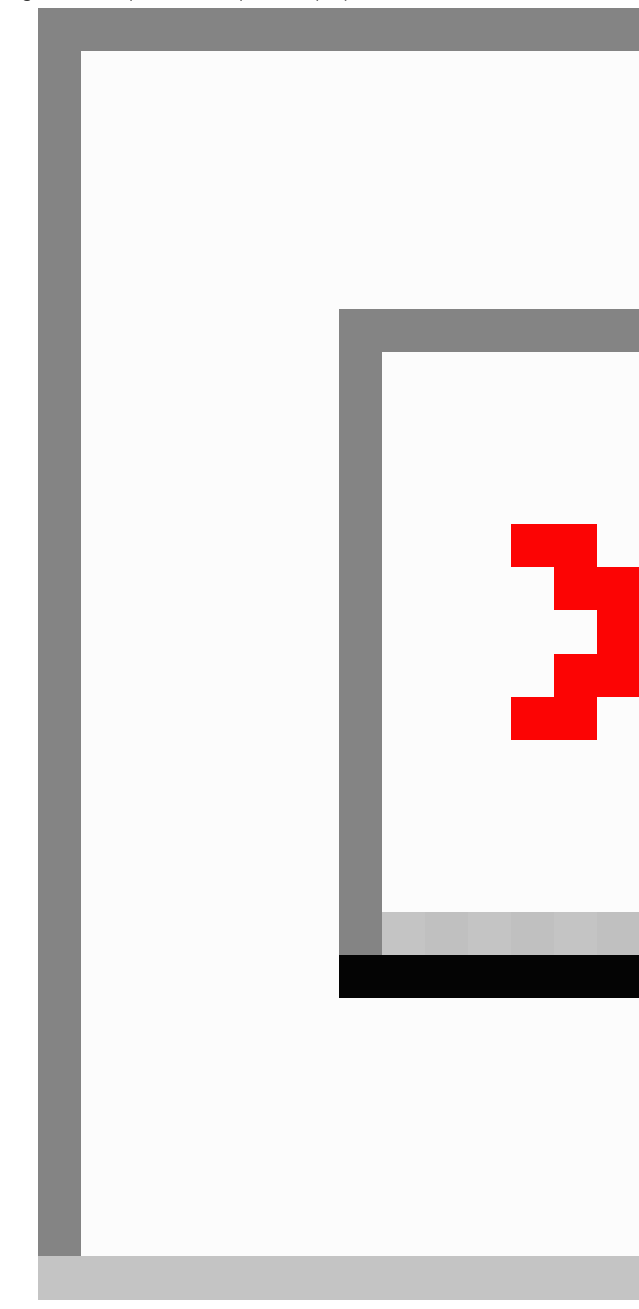
Figure 3. Simplified concept of the proposed